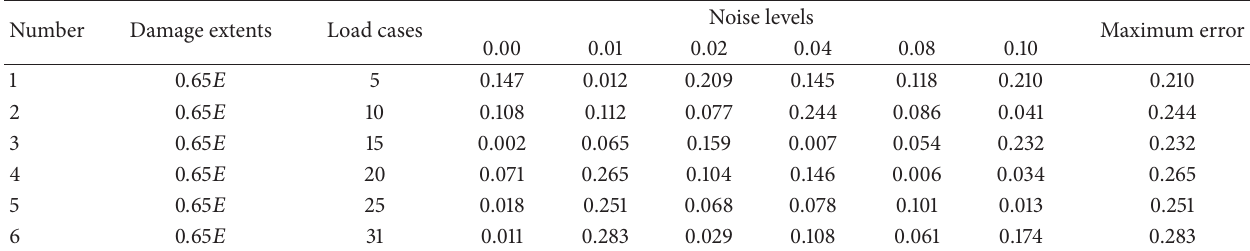
Table 19: The identification errors of forecasted cases based on acceleration damage parameters.